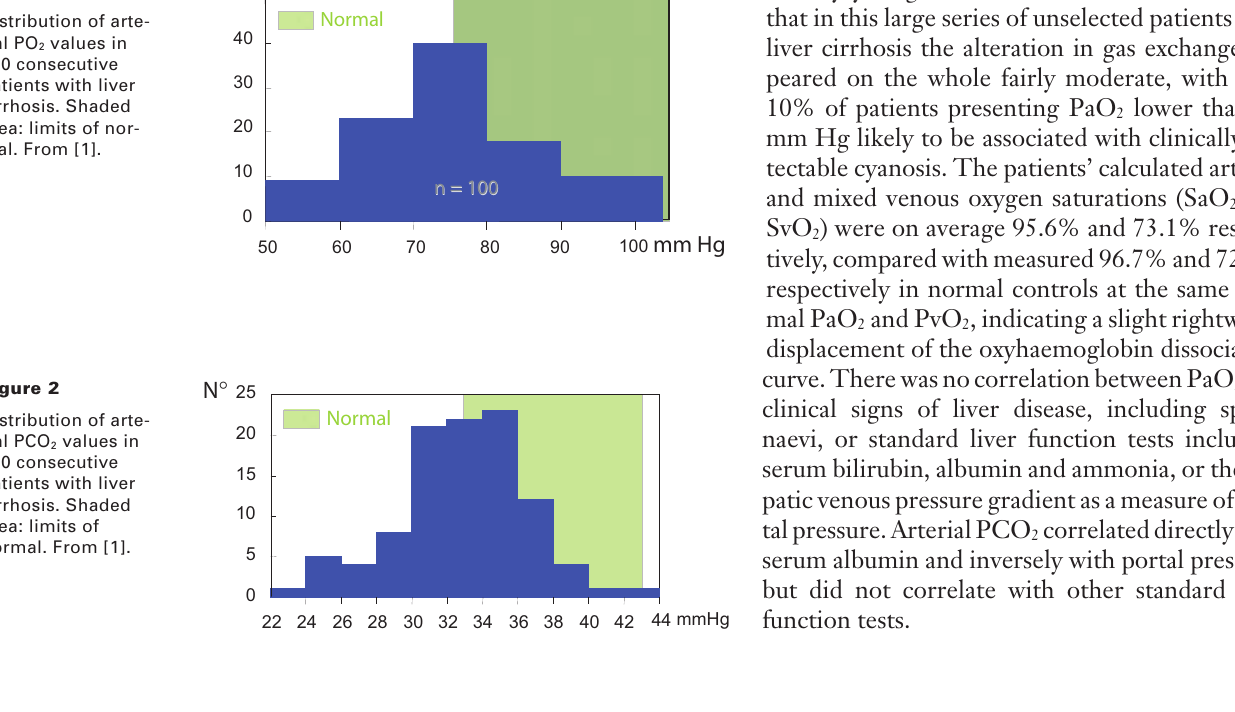
Distribution of arte- rial PO 2 values in 100 consecutive patients with liver cirrhosis. Shaded area: limits of nor- mal. From [1].